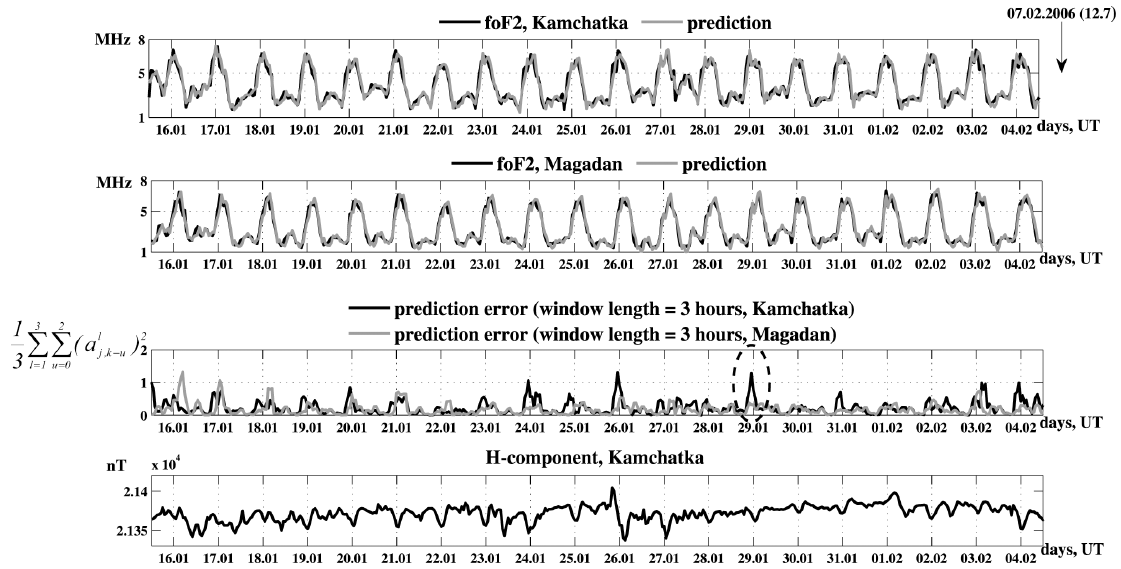
Figure 7. Simulation results for foF2 data from Kamchatka and Magadan for the period 16.01.2006–04.02.2006: prediction was made using model (5) with q =1; the arrow indicates a seismic event in Kamchatka (energy class k =12.7).